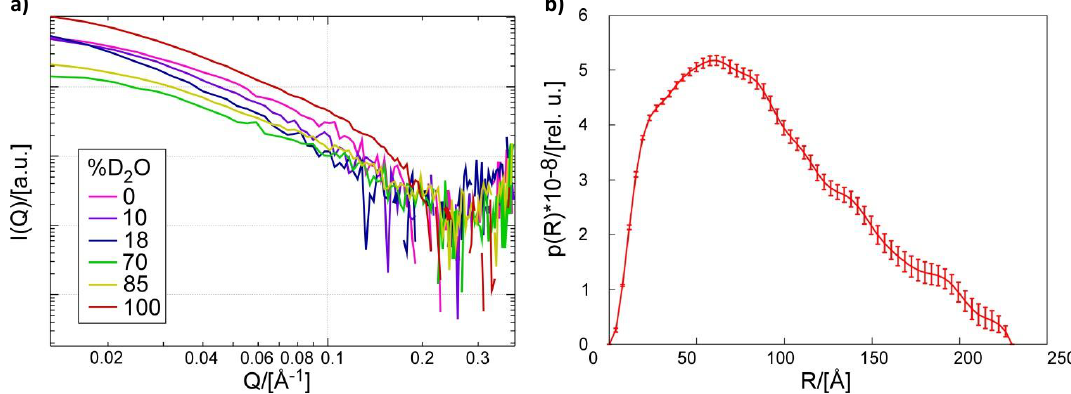
Figure 1. Small Angle Neutron Scattering. ( a ) Scattering curves for Pth1H20R:peptidyl-tRNA complex from contrast series measurements taken at buffer D O concentrations of 0%, 2 10%, 18%, 70%, 85%, and 100%; ( b ) Pairwise distance distribution function of scattering data from complex in 100% D O generated in GNOM 2